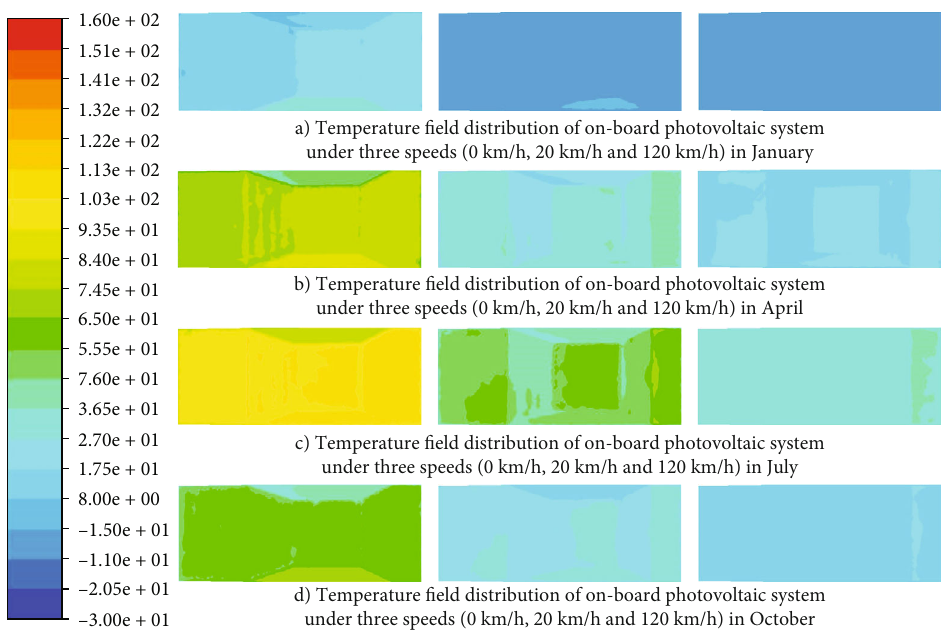
Figure 7: Temperatures of photovoltaic cells at di ff erent speeds in 4 months.